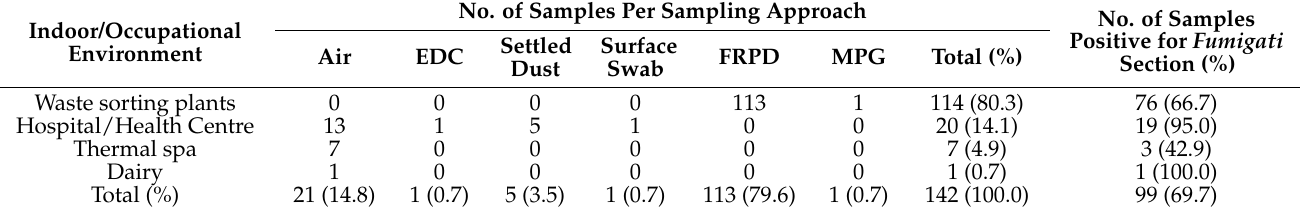
Table 2. Number of samples screened per sampling approach and type of indoor/occupational environment assessed, and number of samples positive for Fumigati